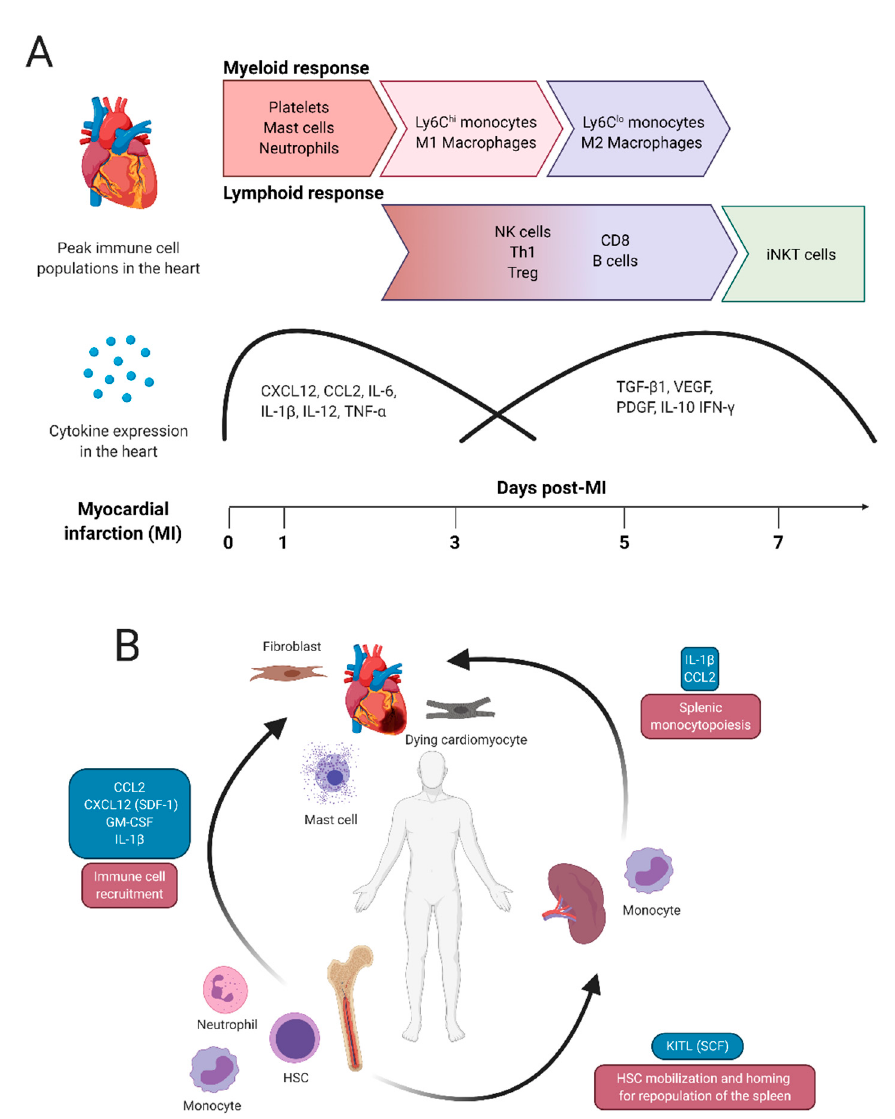
Figure 1. Typical immune cell and tissue responses in the heart after permanent coronary artery occlusion. ( A ) The generalized pattern of immune cell infiltration to the heart after ischemic injury. Here, immune cell infiltrate is subdivided into myeloid and lymphoid populations. Myeloid cell infiltration spans approximately 1–3 days post-MI, while lymphoid cell populations infiltrate the heart at approximately 3–7 days post-MI. ( B ) Systemic tissue response to MI. After MI, signals from the heart (e.g., from degranulating mast cells, dying cardiomyocytes or activated fibroblasts) act on the spleen and bone marrow to initiate tissue repair. The activation of HSCs and migration of immune cells is triggered by a diverse array of molecules, including but not limited to CCL2, CXCL12 (SDF-1), GM-CSF and IL-1 β . Monocytopoiesis is regulated by IL-1 β and CCL-2. Gradually, HSCs in the bone marrow will repopulate the spleen in part through chemotactic molecules such as KITL